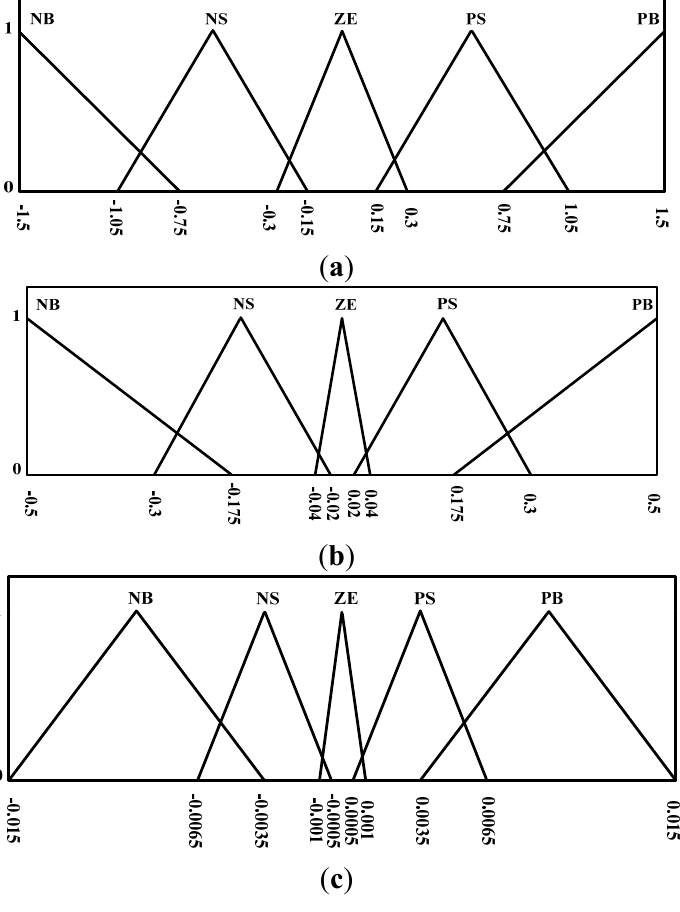
Figure 13. Membership functions for Algorithm (iii): ( a ) Membership function for P-V slope; ( b ) Membership function for changes of slope; ( c ) Membership function for increment of duty ratio